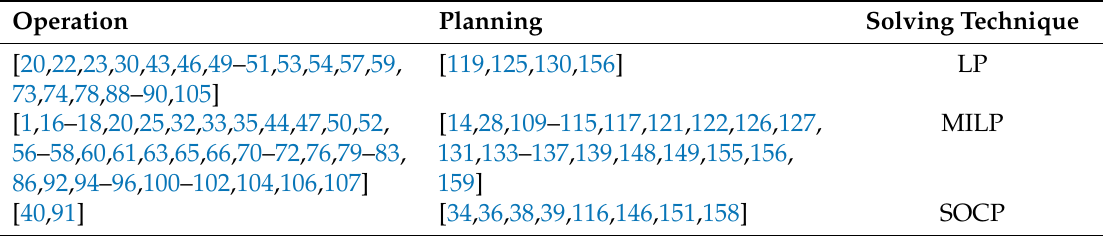
Table 6. Types of mathematical models used in the considered literature. (Abbreviations: LP, linear programming; MILP, mixed-integer linear programming; SOCP, second order cone programming).